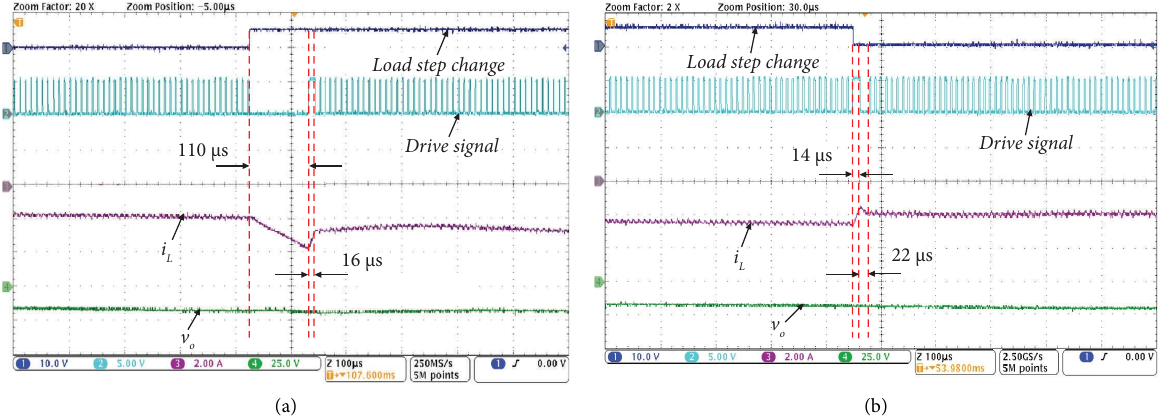
Figure 18: Transient waveforms of the proposed controller at 4 π /3. (a) Step change of i 3.5A to